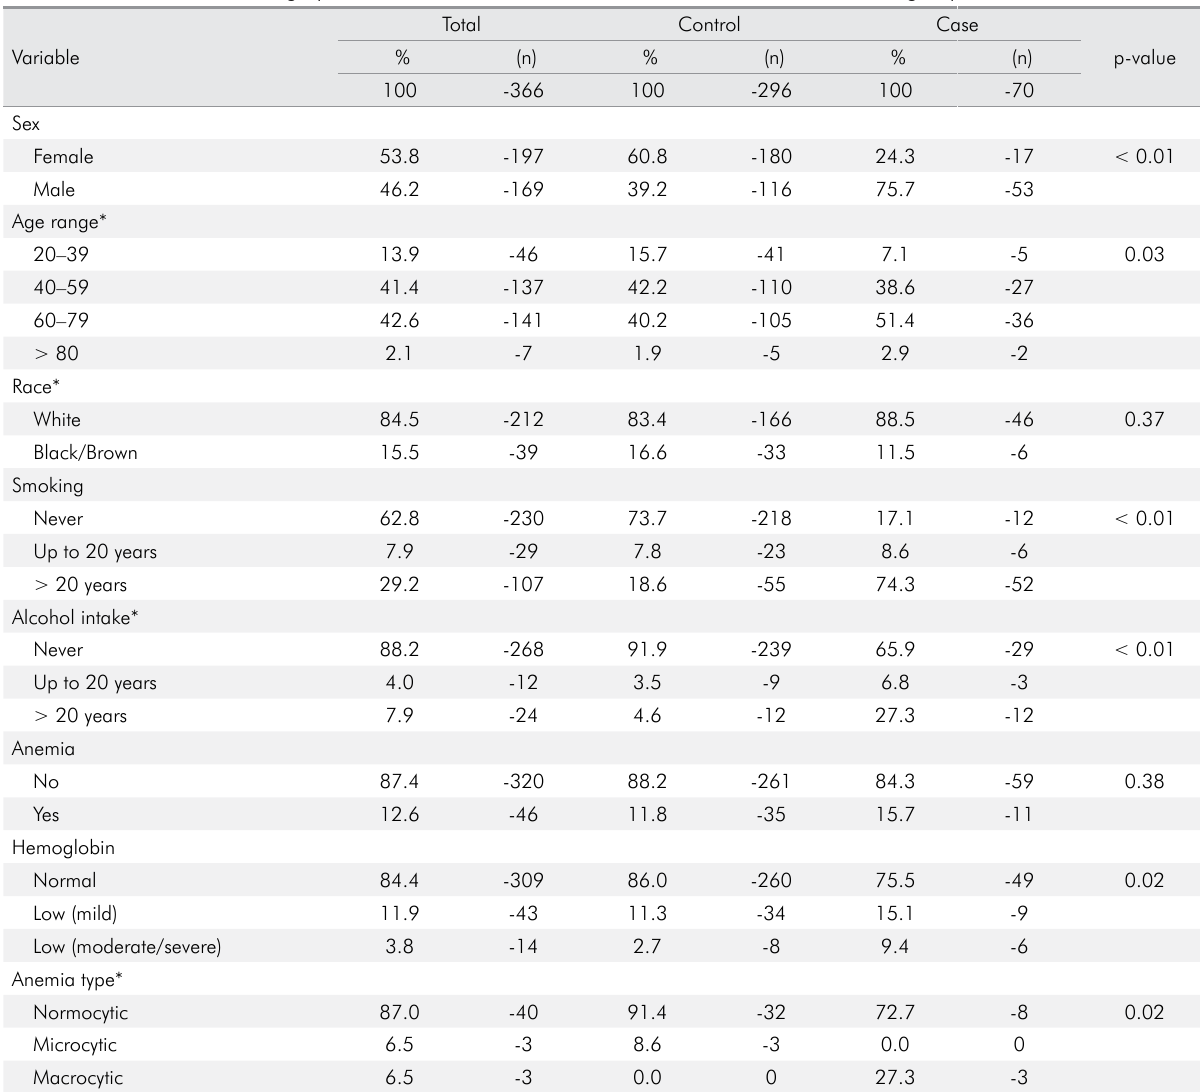
Table 1. Distribution of demographic, behavioral, and clinical variables in the case and control groups.